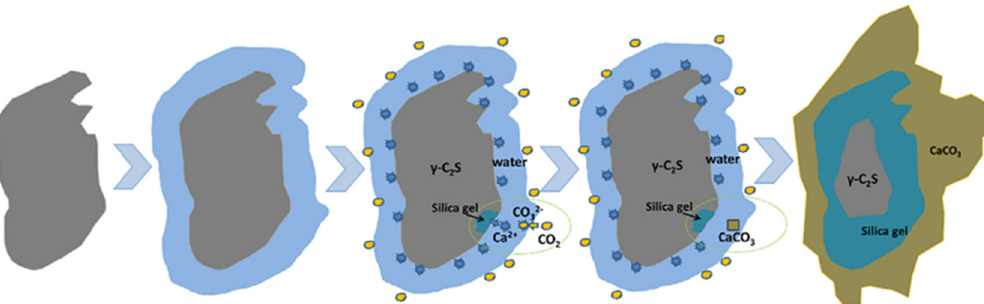
Figure 2. A conceptual carbonation model diagram of the γ− C 2 S particle [37], adapted from [37], with permission from Elsevier, 2021.